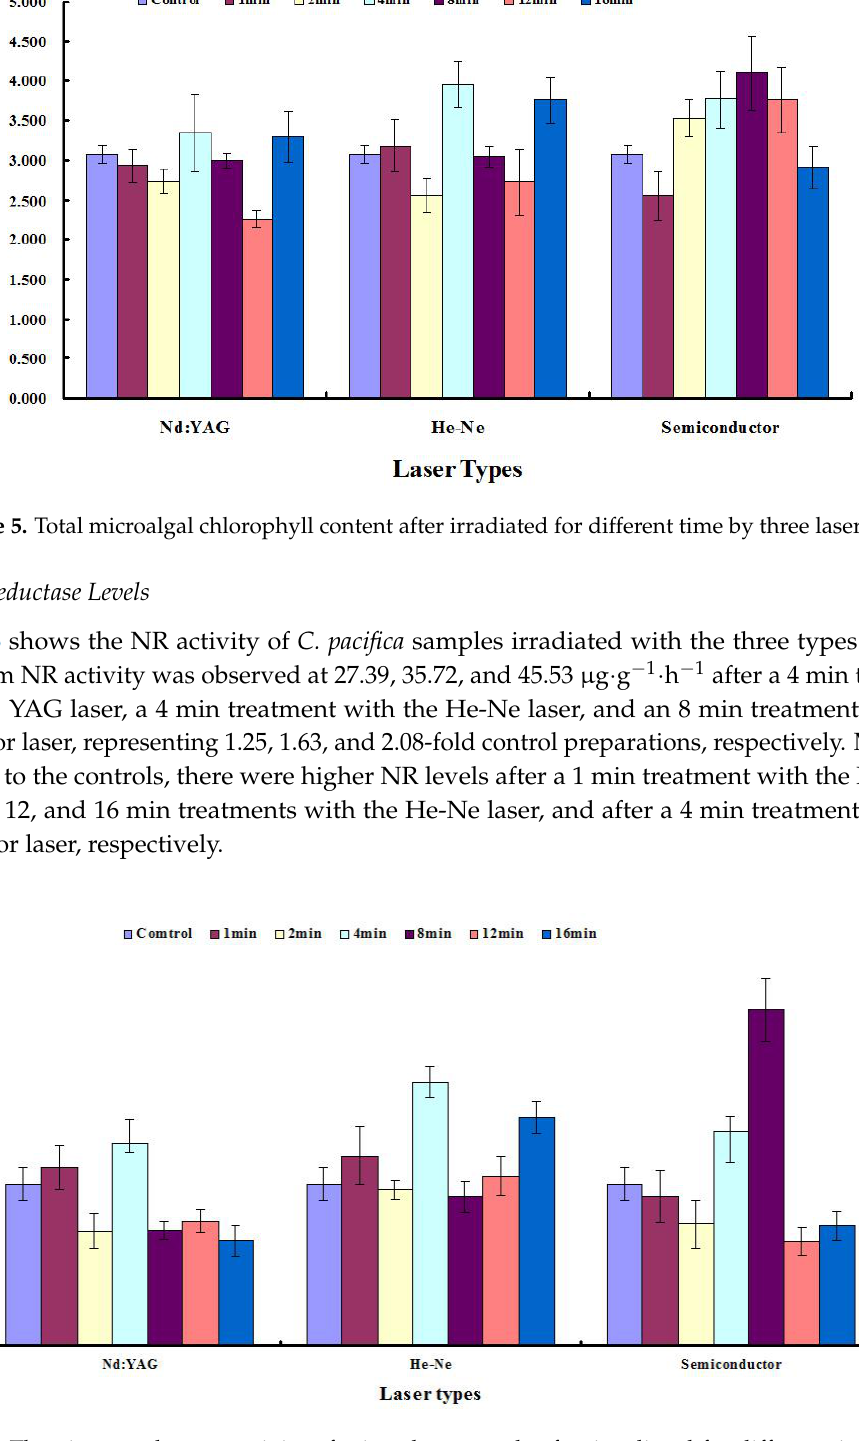
Figure 6. The nitrate reductase activity of microalgae sample after irradiated for different time by three type of lasers.